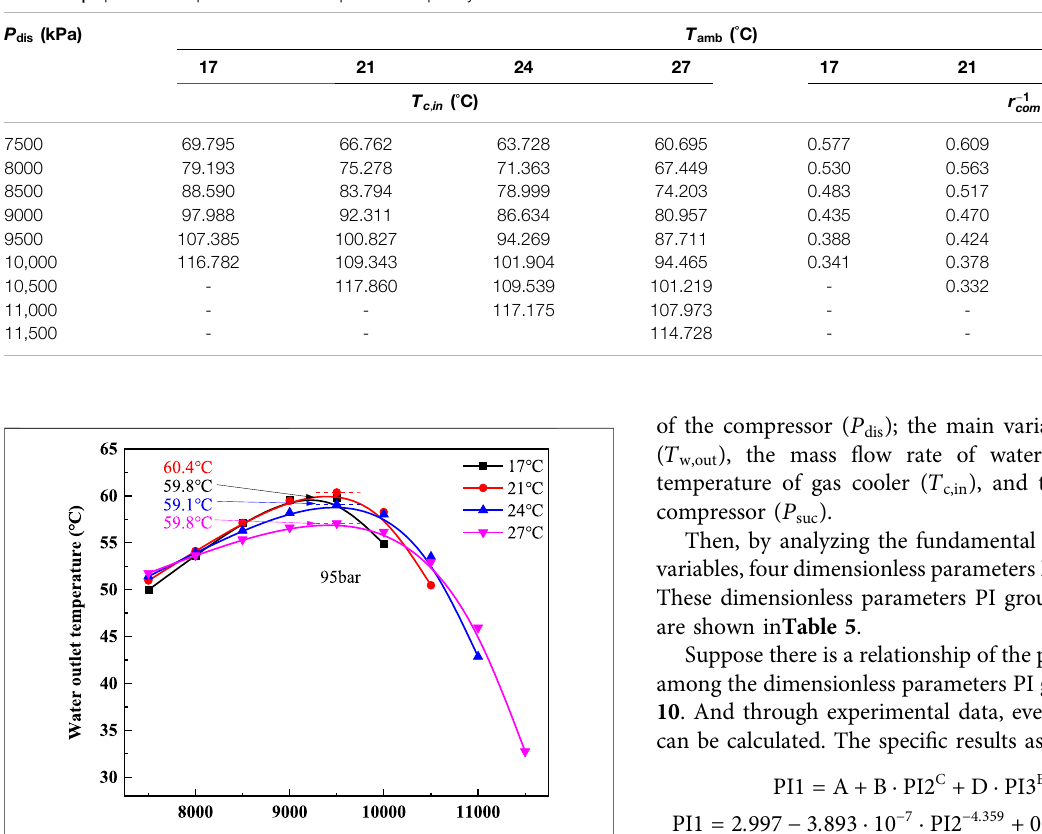
TABLE 6 | Input variable parameters at compressor frequency of 20Hz.